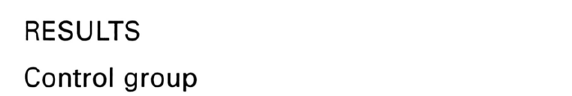
Behavioural Neurology. Vol 9 •